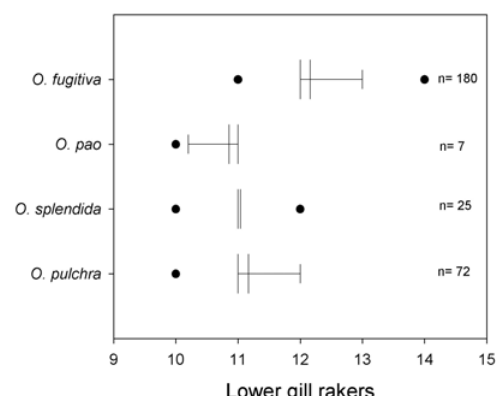
Fig. 18. Lower gill rakers counts of Odontostilbe pulchra , Odontostilbe fugitiva (data from Bührnheim & Malabarba, 2006), and of two new species Odontostilbe splendida , and Odontostilbe pao